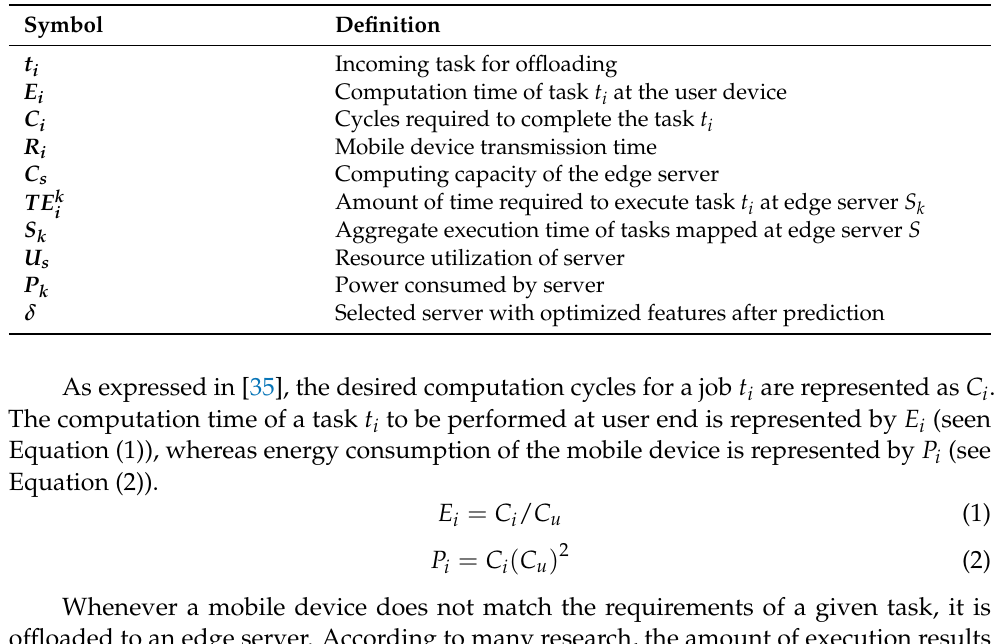
Table 1. Symbols and